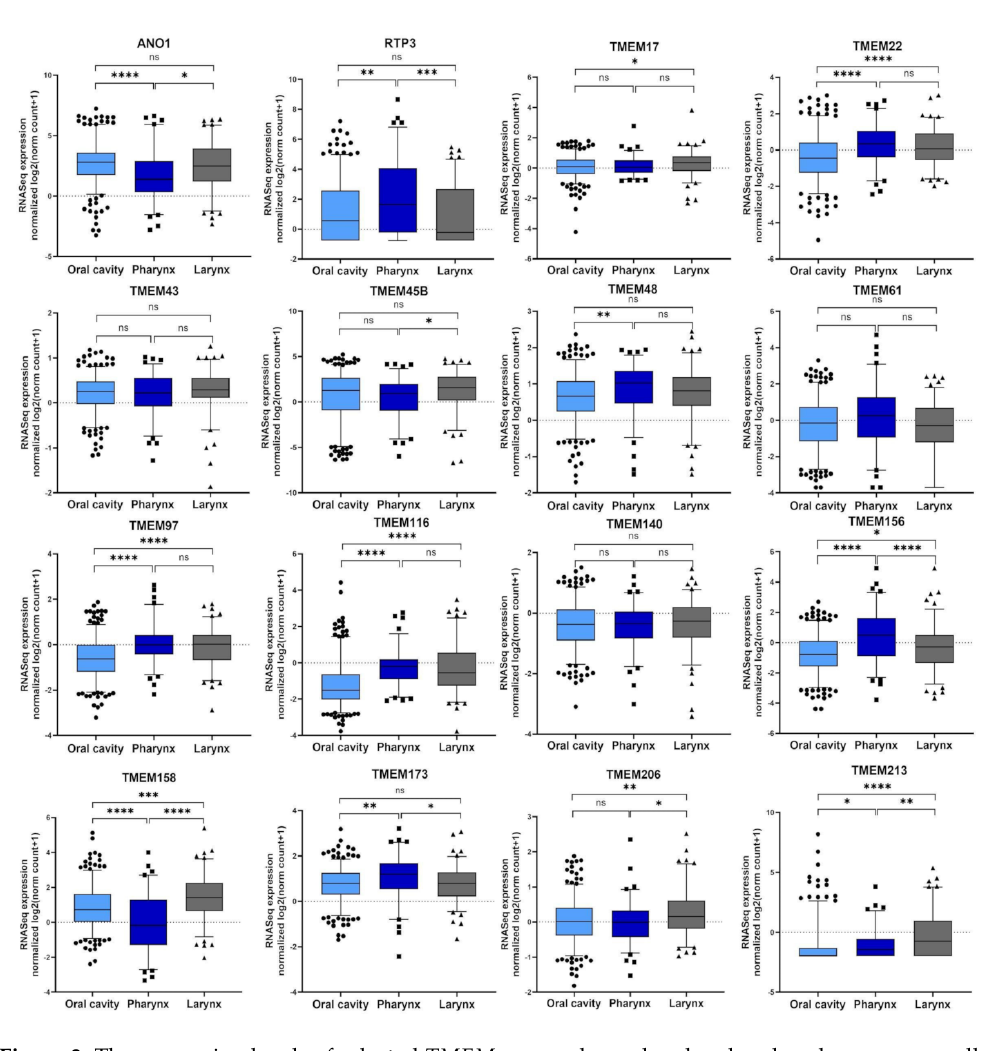
Figure 3. The expression levels of selected TMEMs genes depend on head and neck squamous cell carcinoma (HNSCC) localization in oral cavity ( n = 316), pharynx ( n = 90), and larynx ( n = 116); ns : not significant; * p < 0.05; ** p < 0.01; *** p < 0.001; **** p <